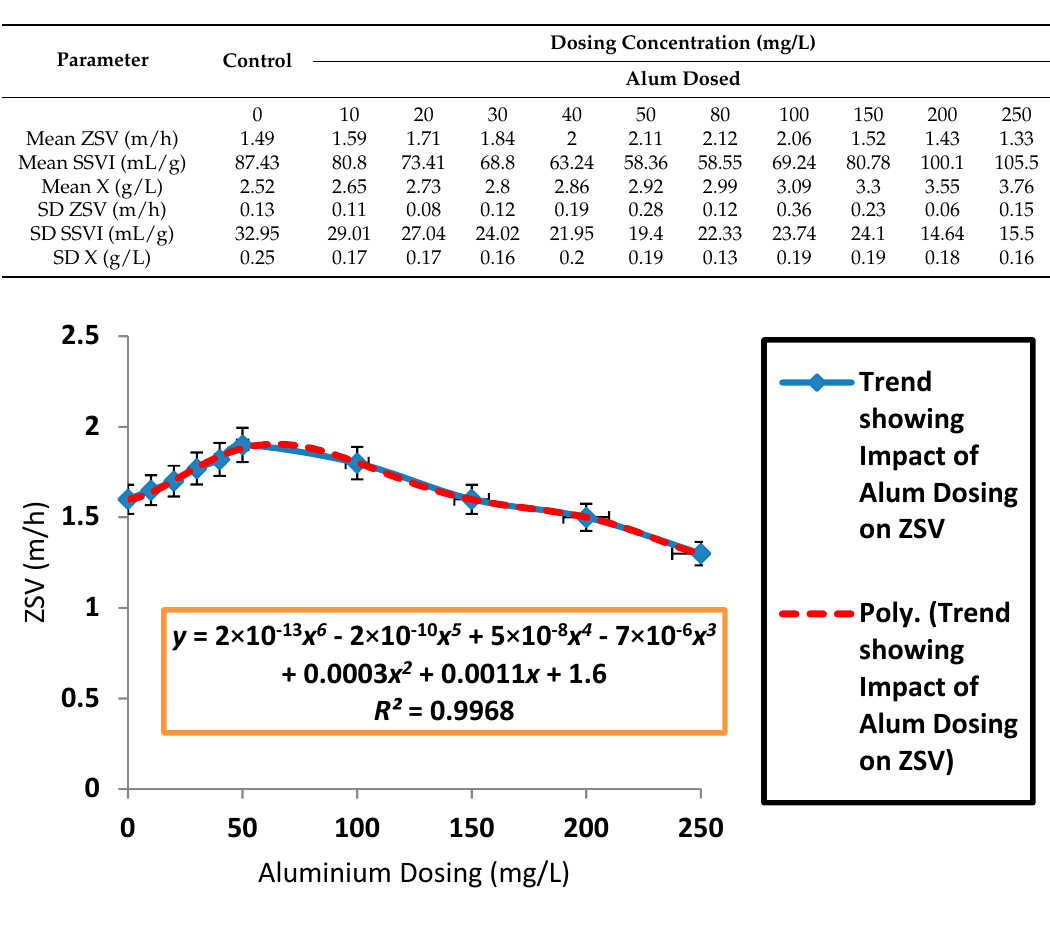
Figure 3. The impact of Al dosing (mg/L) on ZSV (m/h) (error bars represent standard deviation of the mean).